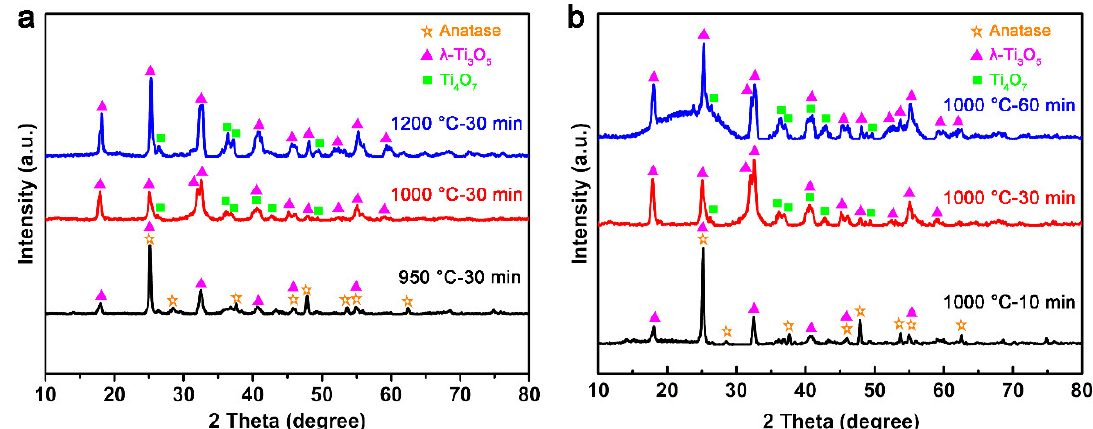
Figure 2. XRD images of nanofibers with ( a ) a different calcination temperature and ( b ) holding time.